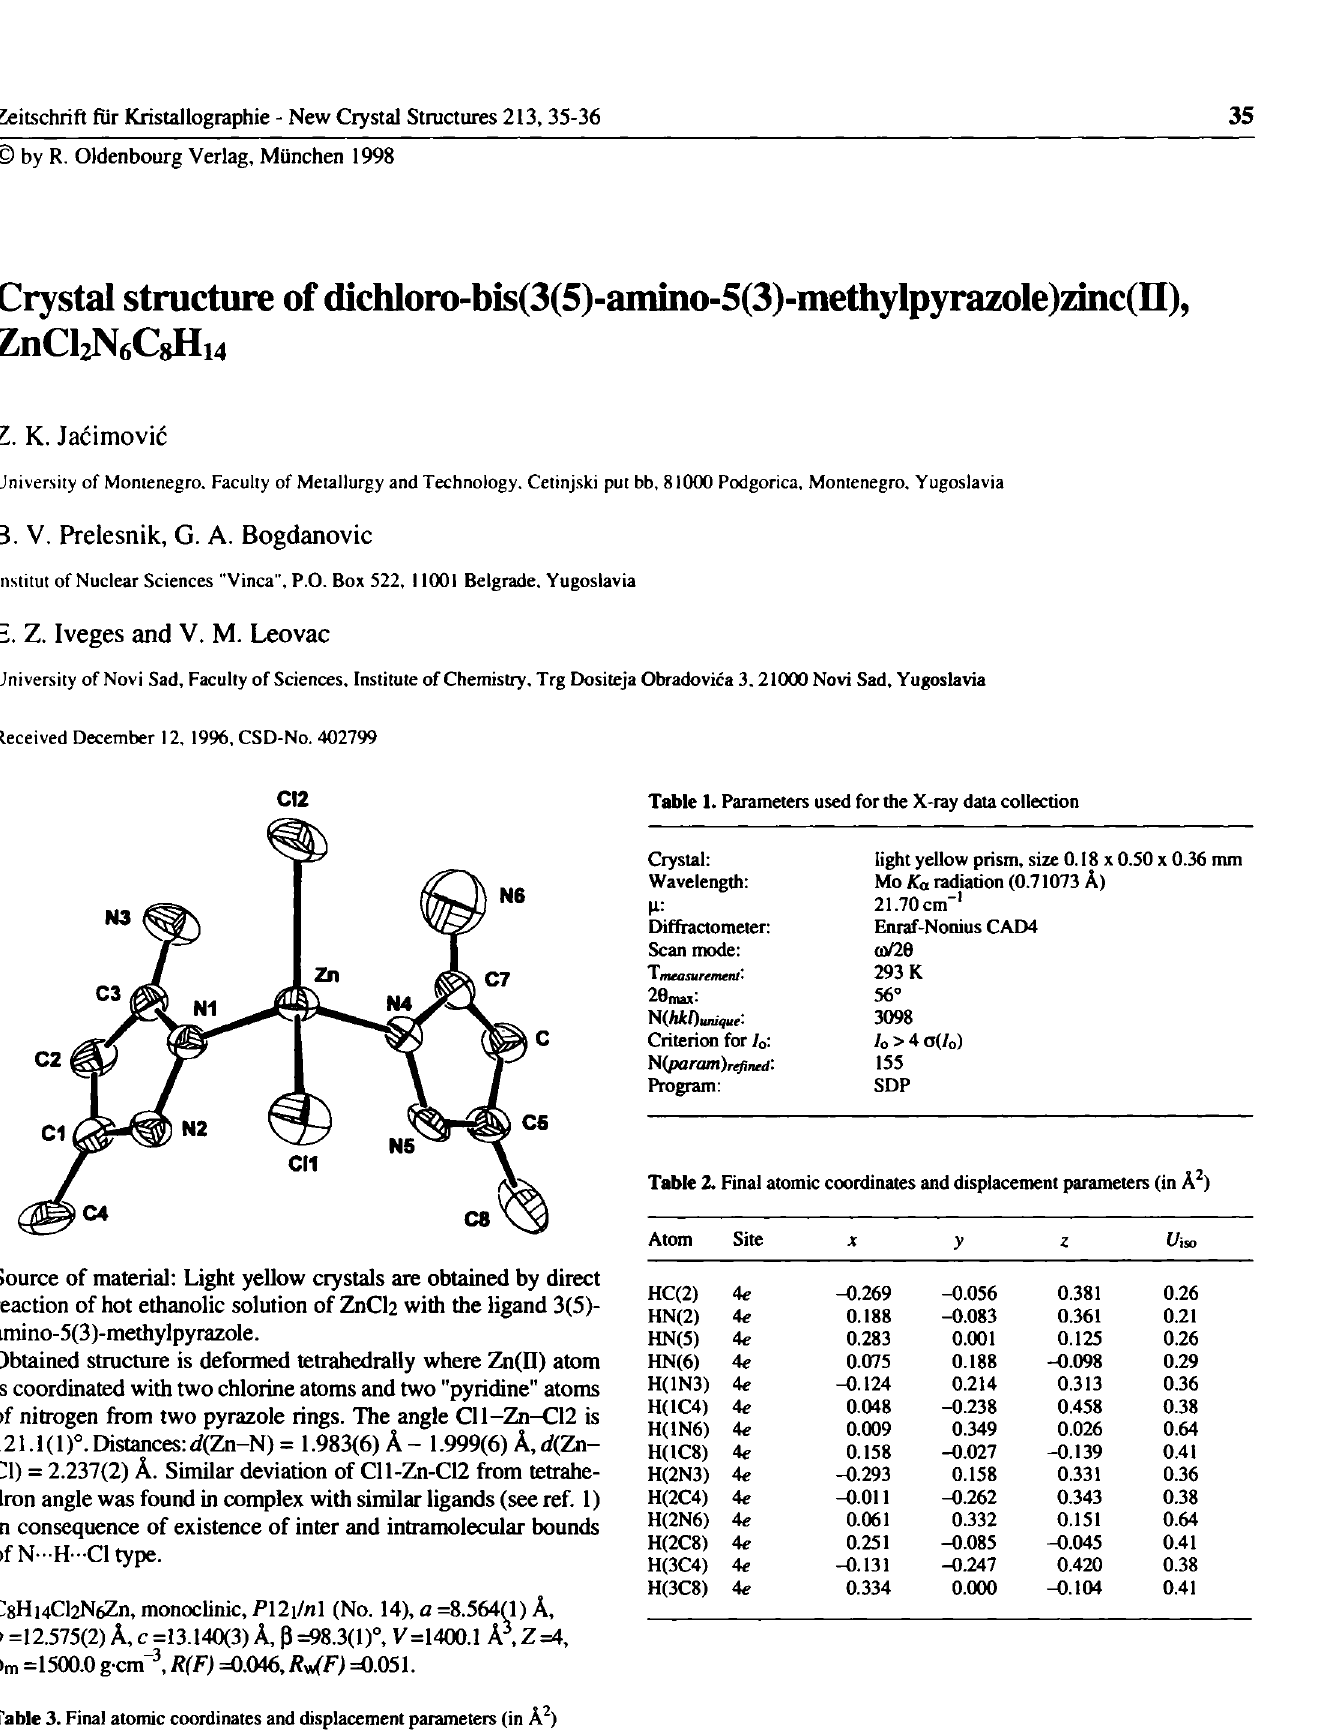
Table 3. Final atomic coordinates and displacement parameters (in Â^)